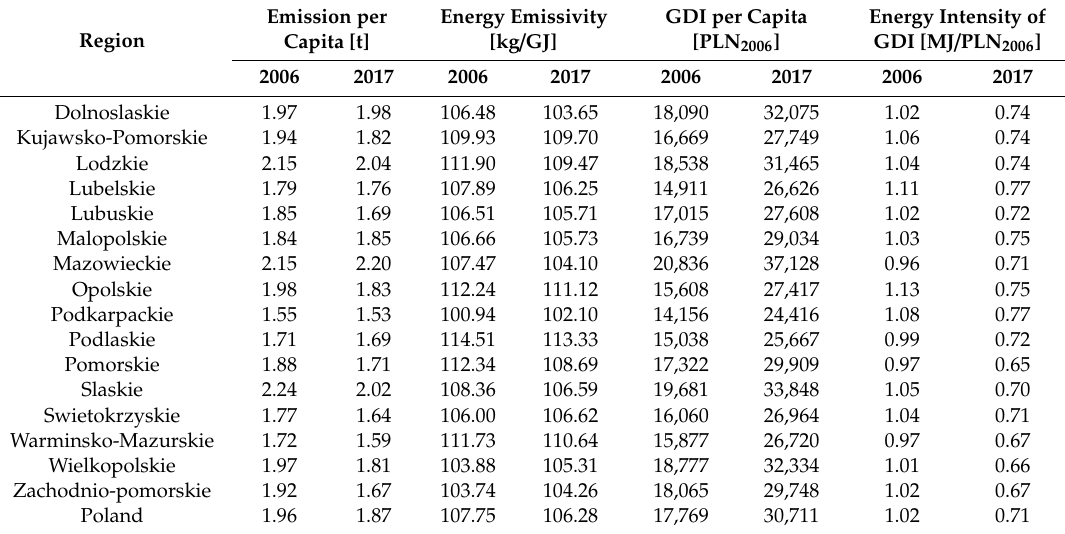
Table 3. Indicators used for estimation of energy use and CO 2 emissions. Source: Data from [59–61]. Fuel electricity hard coal